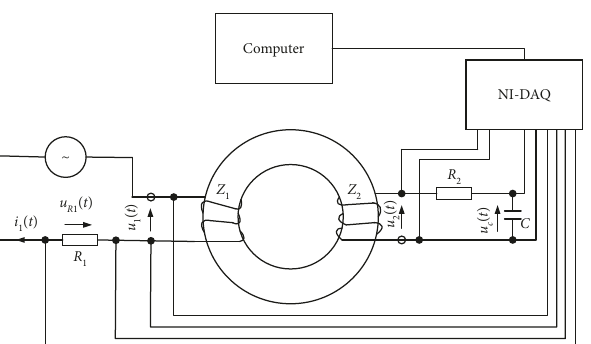
Figure 3: Scheme of connection for the measurement